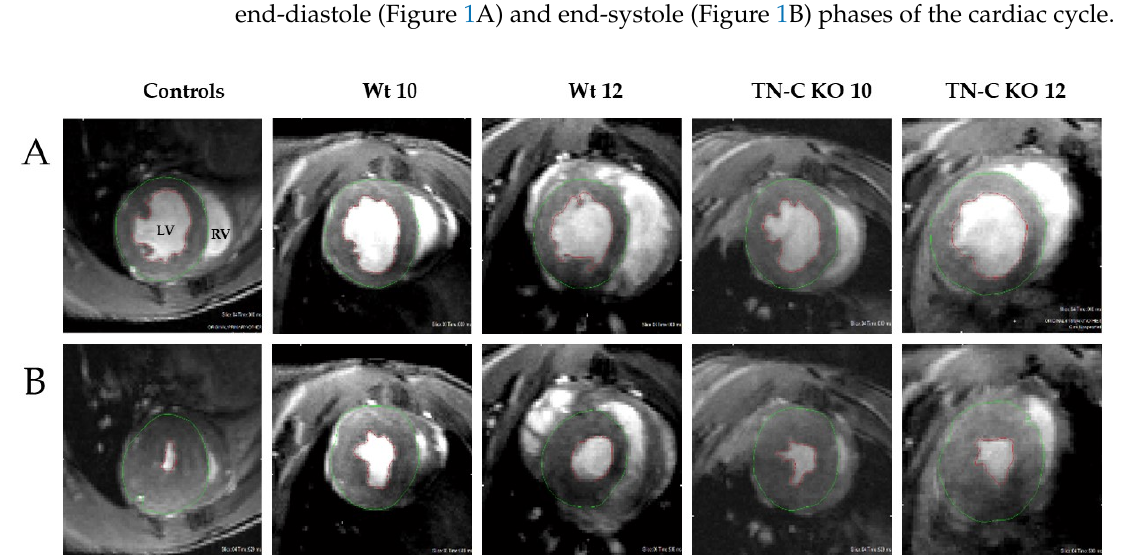
Statistical differences are indicated with asterisks (*** for p < 0.001, and ** for p < 0.01) between controls and 10-week banding groups and ## for p < 0.01 between Wt 10 and Wt 12 groups. BW: body weight; HW: heart weight; LVM: left ventricular mass, LW: wet lung weight.